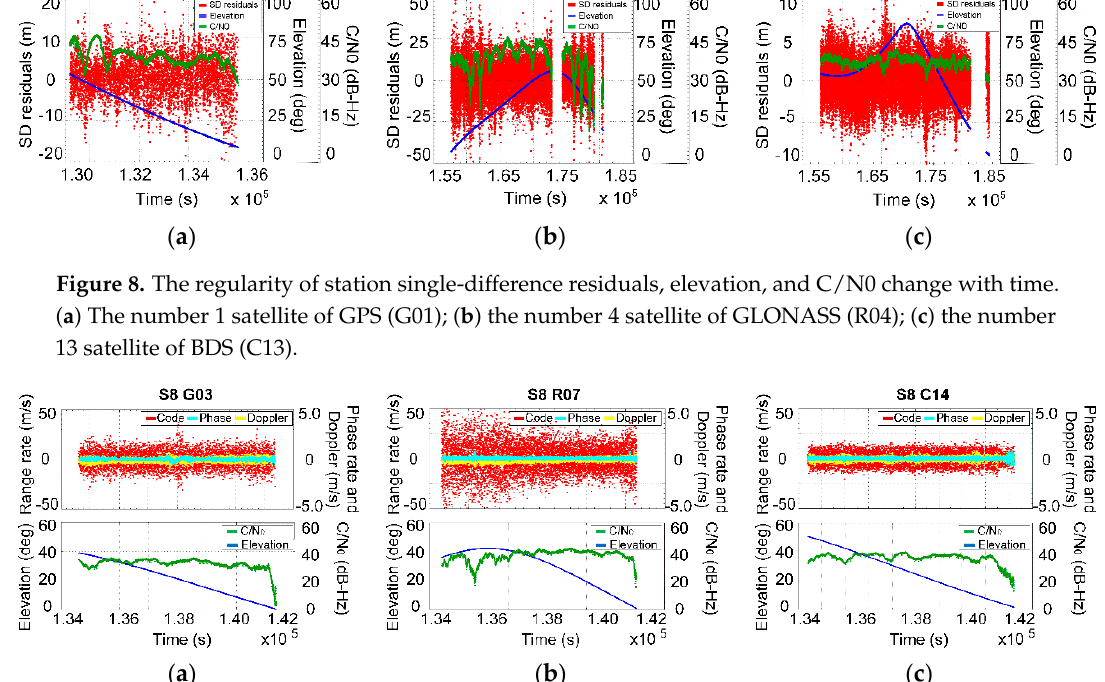
Figure 8. The regularity of station single-difference residuals, elevation, and C/N0 change with time. ( a ) The number 1 satellite of GPS (G01); ( b ) the number 4 satellite of GLONASS (R04); ( c ) the number 13 satellite of BDS (C13).